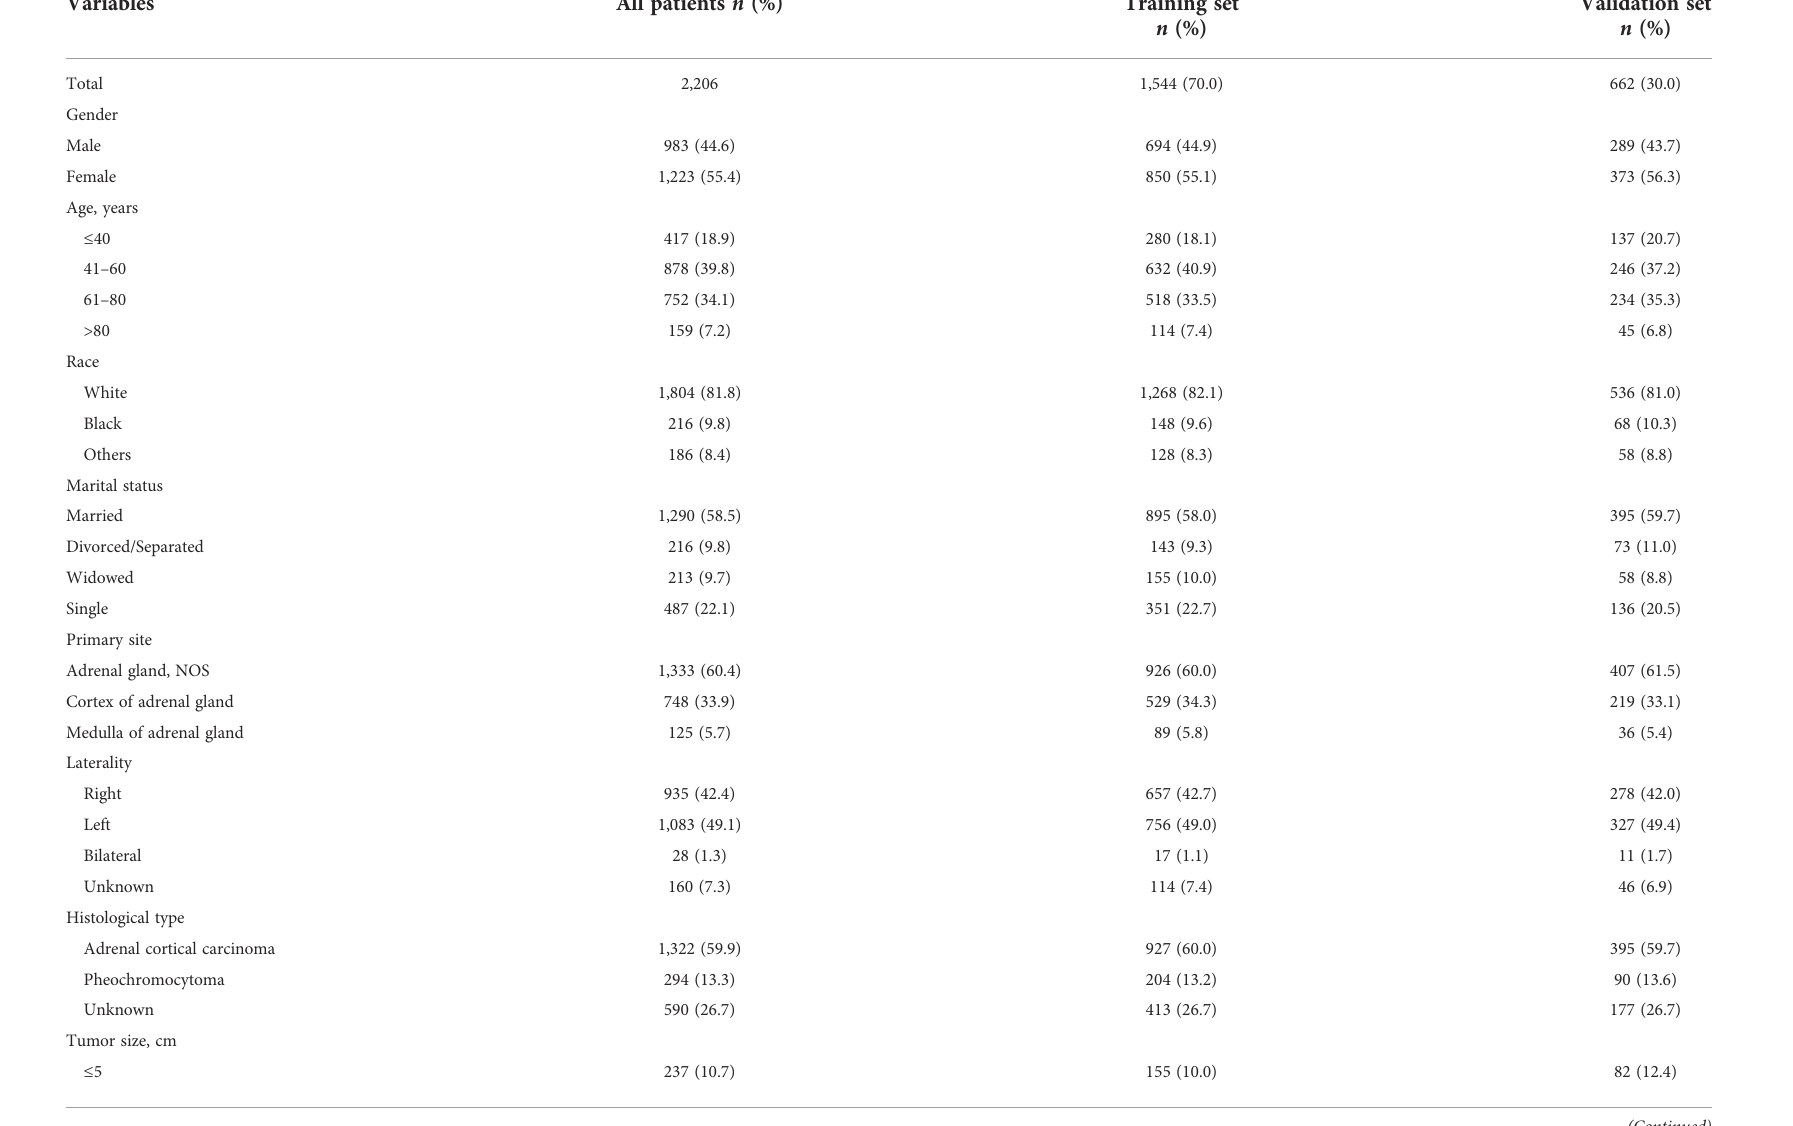
TABLE 1 Baseline demographic and clinical